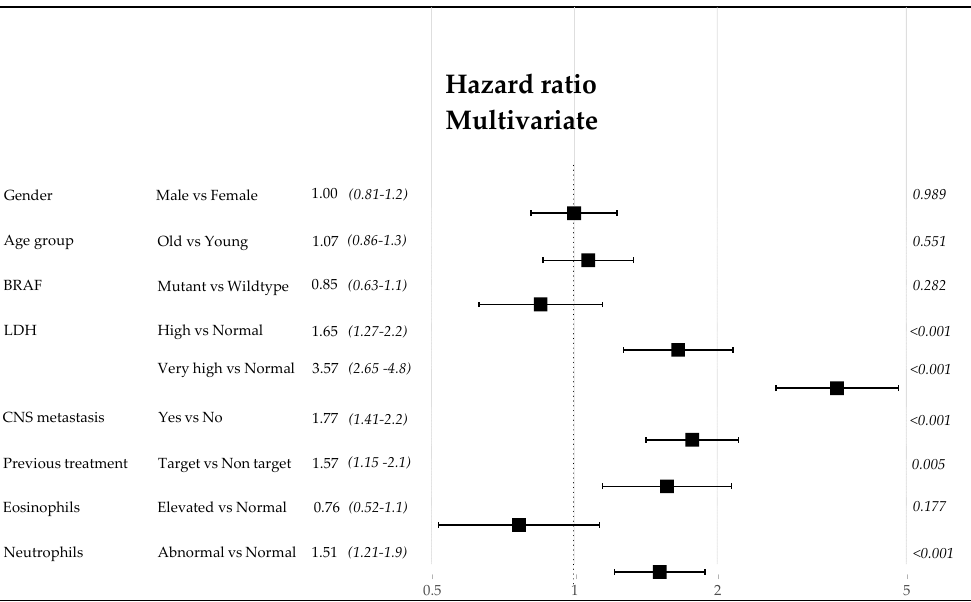
Figure 7. Forest plot of the clinical variables. The hazard ratio and 95% CI are described as well as the p -value. Table 4. CLICAL algorithm scores and signatures related to 503 out of 578 patients. CLICAL algorithm outcomes in scores and grouped in signatures defined by the cumulative risk at 32 months.